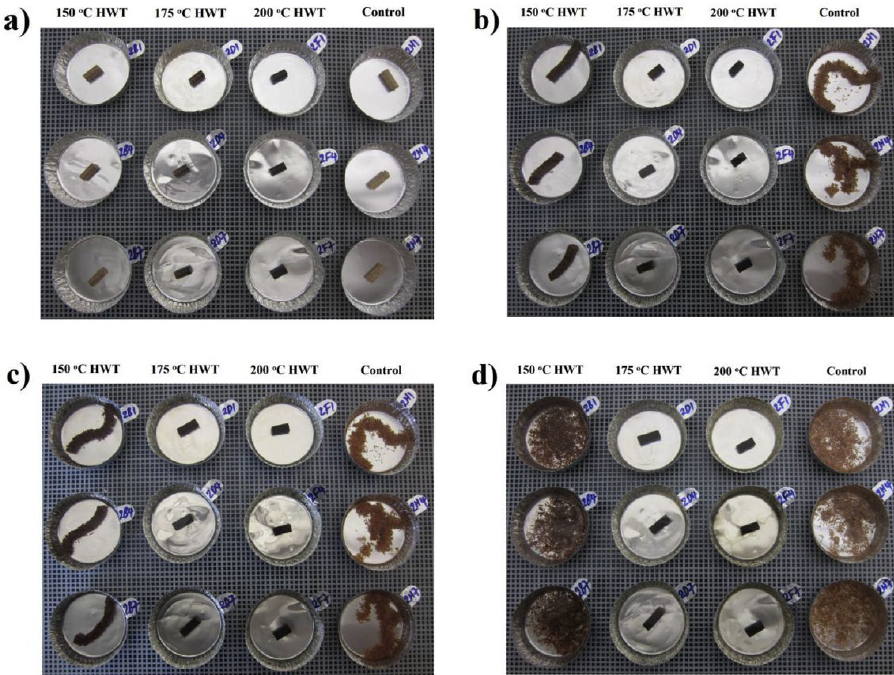
Figure 9. Water immersion tests: appearance of the pellets before being immersed in water ( a ), and after immersion for 5 min ( b ), 24 h ( c ), and 1 week ( d ) in distilled water at 23 °C. Adapted with permission from Ref. [95]. 2017, Elsevier.